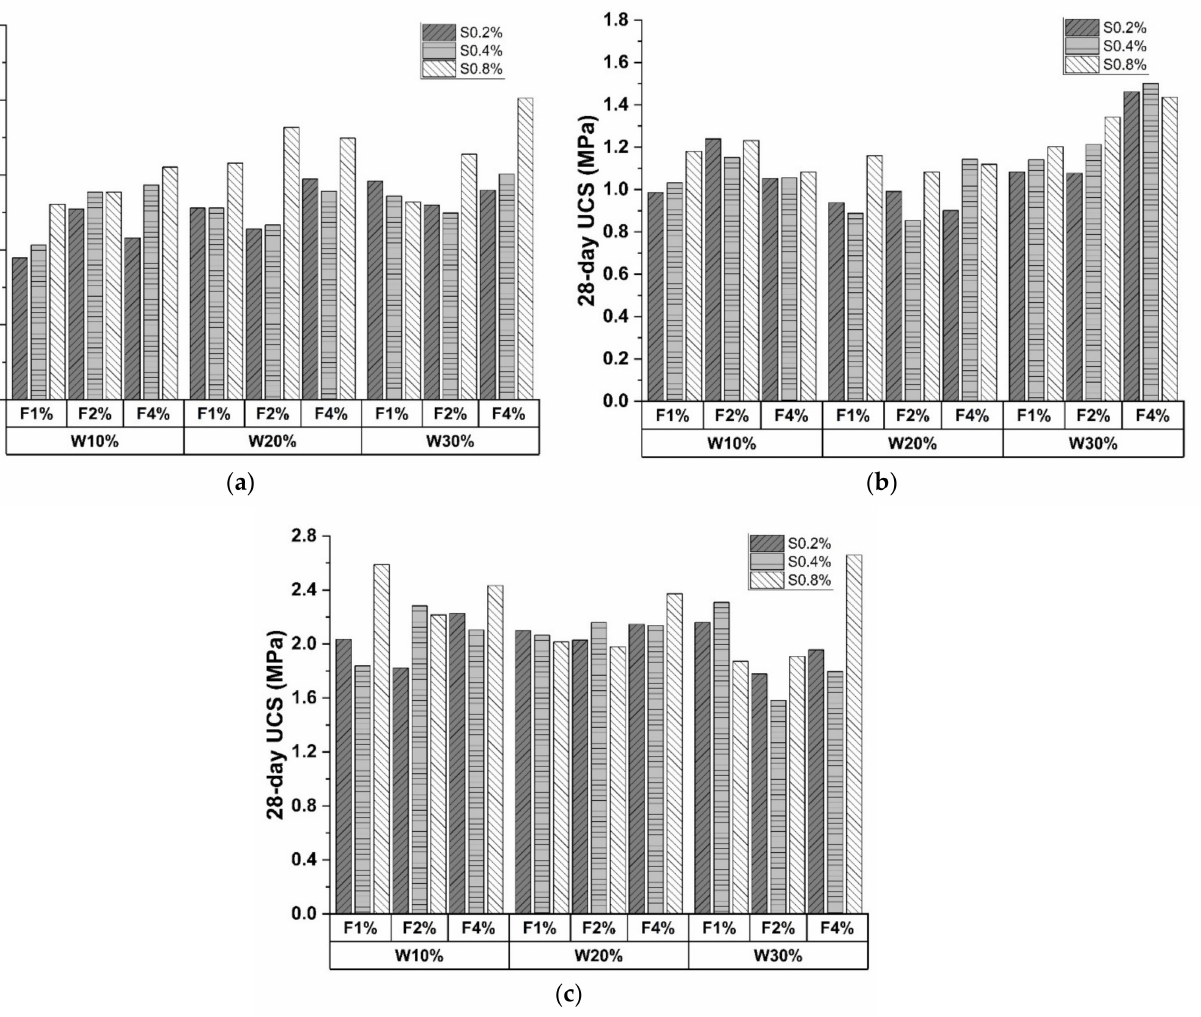
Figure 8. A 28-day UCS of CSS specimens with ( a ) 10% cement; ( b ) 20% cement; ( c ) 30% cement (Note: W represents C&D waste; S represents sodium sulfate; F represents polypropylene